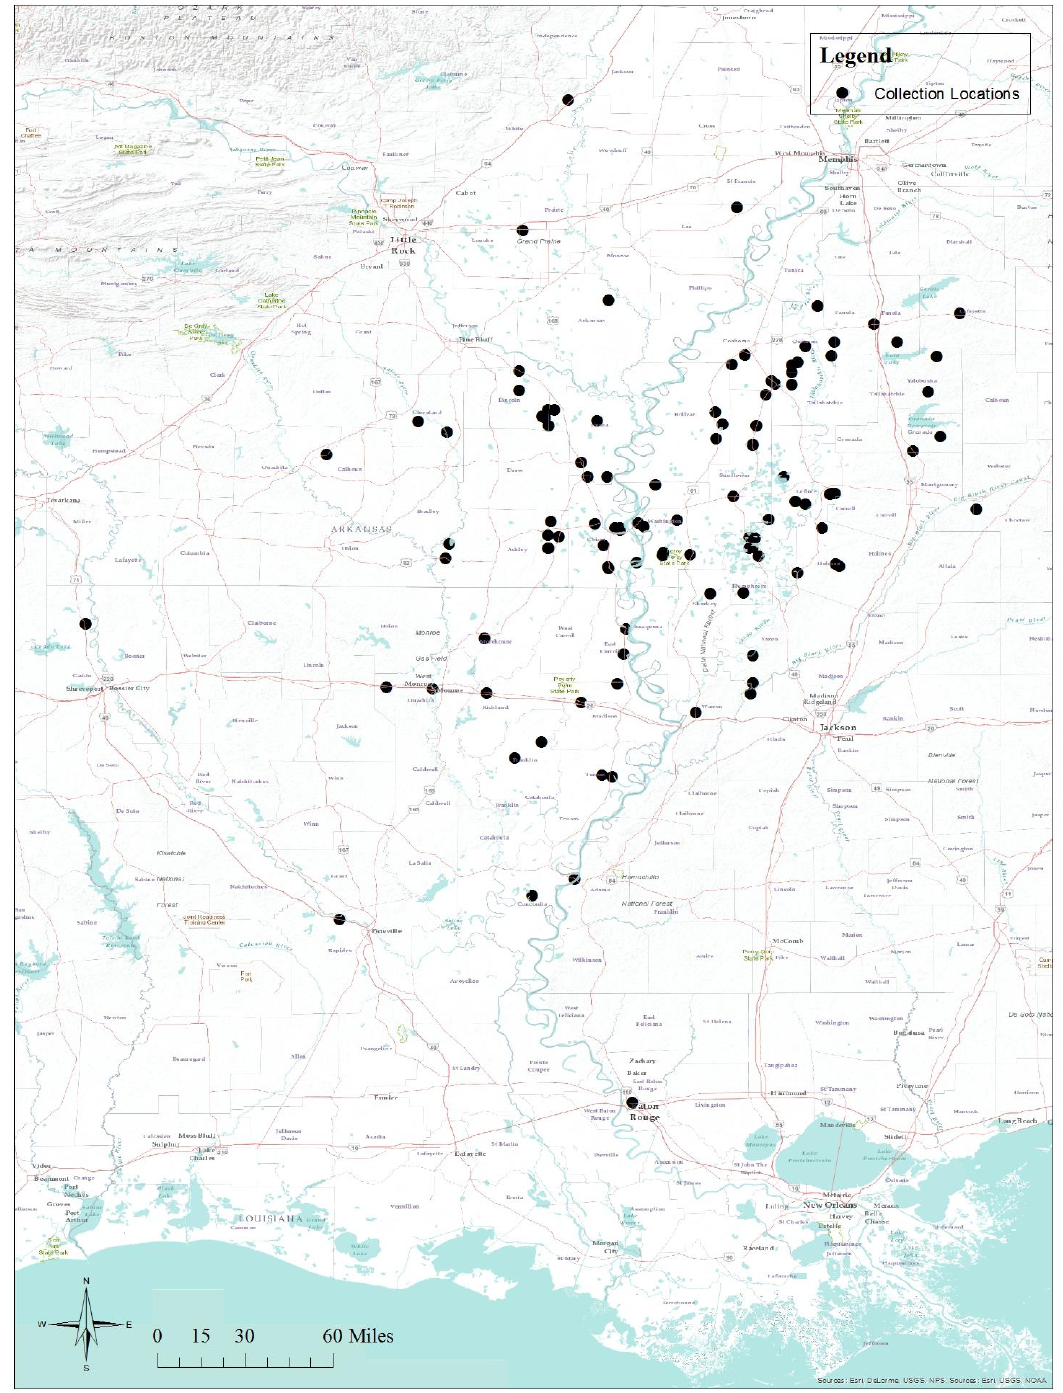
Figure 1. Geographic sites of tarnished plant bug collections in Arkansas, Louisiana, and Mississippi for insecticide assays, 2008–2015.